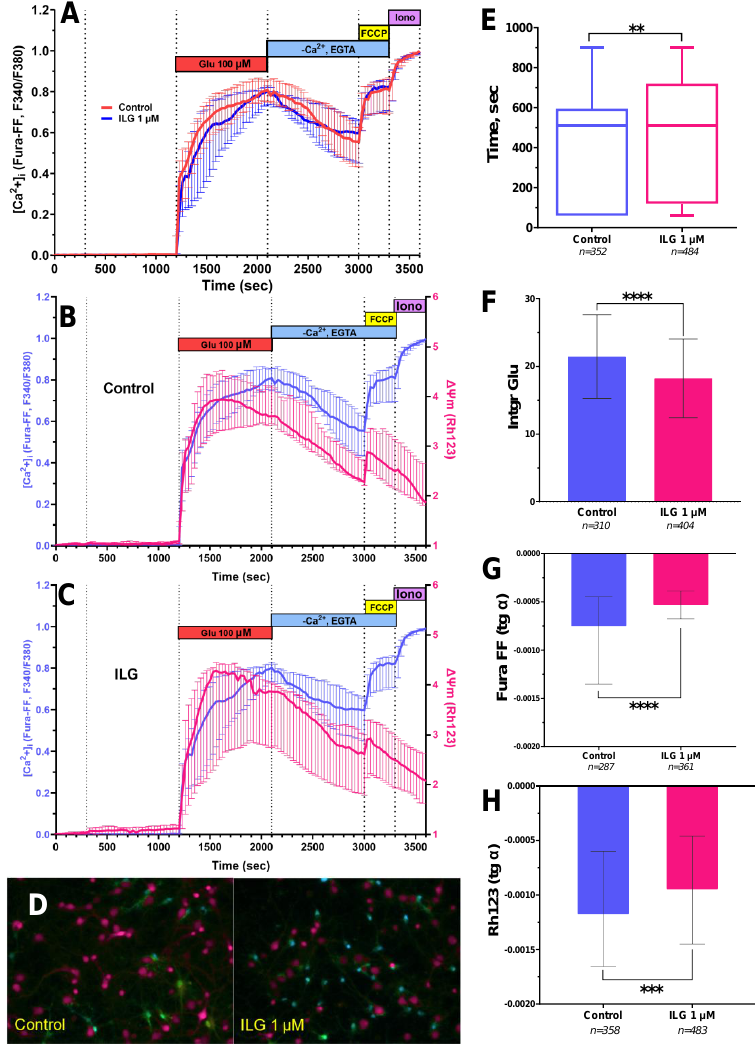
Figure 2. Effect of ILG on the calcium homeostasis and mitochondrial potential ( ∆Ψ m) in primary neuroglial culture cells under conditions of glutamate excitotoxicity. ** p < 0.005, *** p < 0.001, **** p < 0.0001. ( A ) Averaged dynamics of Fura-FF fluorescent signal changes during the experiment are presented as Median with IQR. ( B ) Synchronous changes in [Ca 2+ ] i and ∆Ψ m measured with calcium indicator Fura-FF and a potential sensitive probe Rh123, respectively, in control cell cultures, and ( C ) during ILG exposure. Changes in [Ca 2+ ] i are presented as ratios of fluorescent Ca 2+ indicator Fura-FF signals measured at 340 and 380 nm excitation (F340/F380) and recorded at 525 nm. In each neuron, the F340/F380 ratio is normalized to the baseline value at rest. Changes in Rh123 fluorescence (excitation: 485 nm; emission: 525 nm) are presented as the ratio F/Fo, where F is the current fluorescence intensity, and Fo is its value at the beginning of the experiment. Curves are presented as Median ± CI. ( D ) Fluorescent images of cell cultures after glutamate addition in control group and in group with ILG exposure from representative experiments are presented. ( E ) Lag-phase before the onset of delayed calcium deregulation. ( F ) The integrated fluorescent response reflects the change in fluorescence intensity of Fura-FF in cells during the 15 min action of glutamate or glutamate with 1 µ M ILG. ( G ) The slopes (tg α ) of linear approximations of the signal curve of the potential-sensitive fluorescent dye Fura-FF during application of EGTA solution. ( H ) The slopes (tg α ) of linear approximations of the signal curve of the potential-sensitive fluorescent dye Rh123 during application of EGTA solution. There were 6 different experimental cell cultures. n —number of